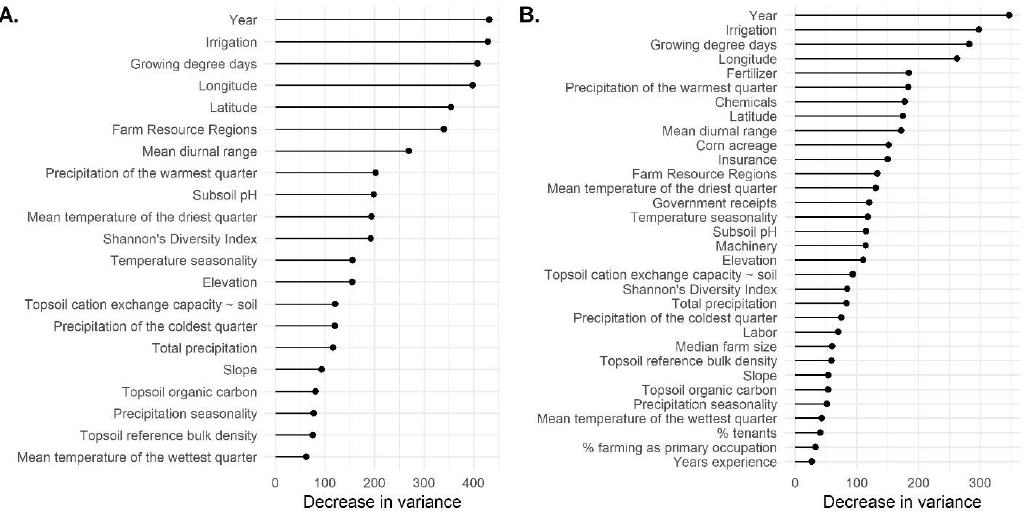
Figure 2. Permutation variable importance for the ( A ) biophysical and ( B ) farmer RF resubstitution models of corn yield. The covariates appear on the y-axis and their contribution to decreased variance on the x-axis. Variables are listed in order of importance, with the most important variable being year and least important being mean temperature of the wettest quarter in panel ( A ), and years of experience in panel ( B ); see Table S1 for variable names, units, and descriptions.